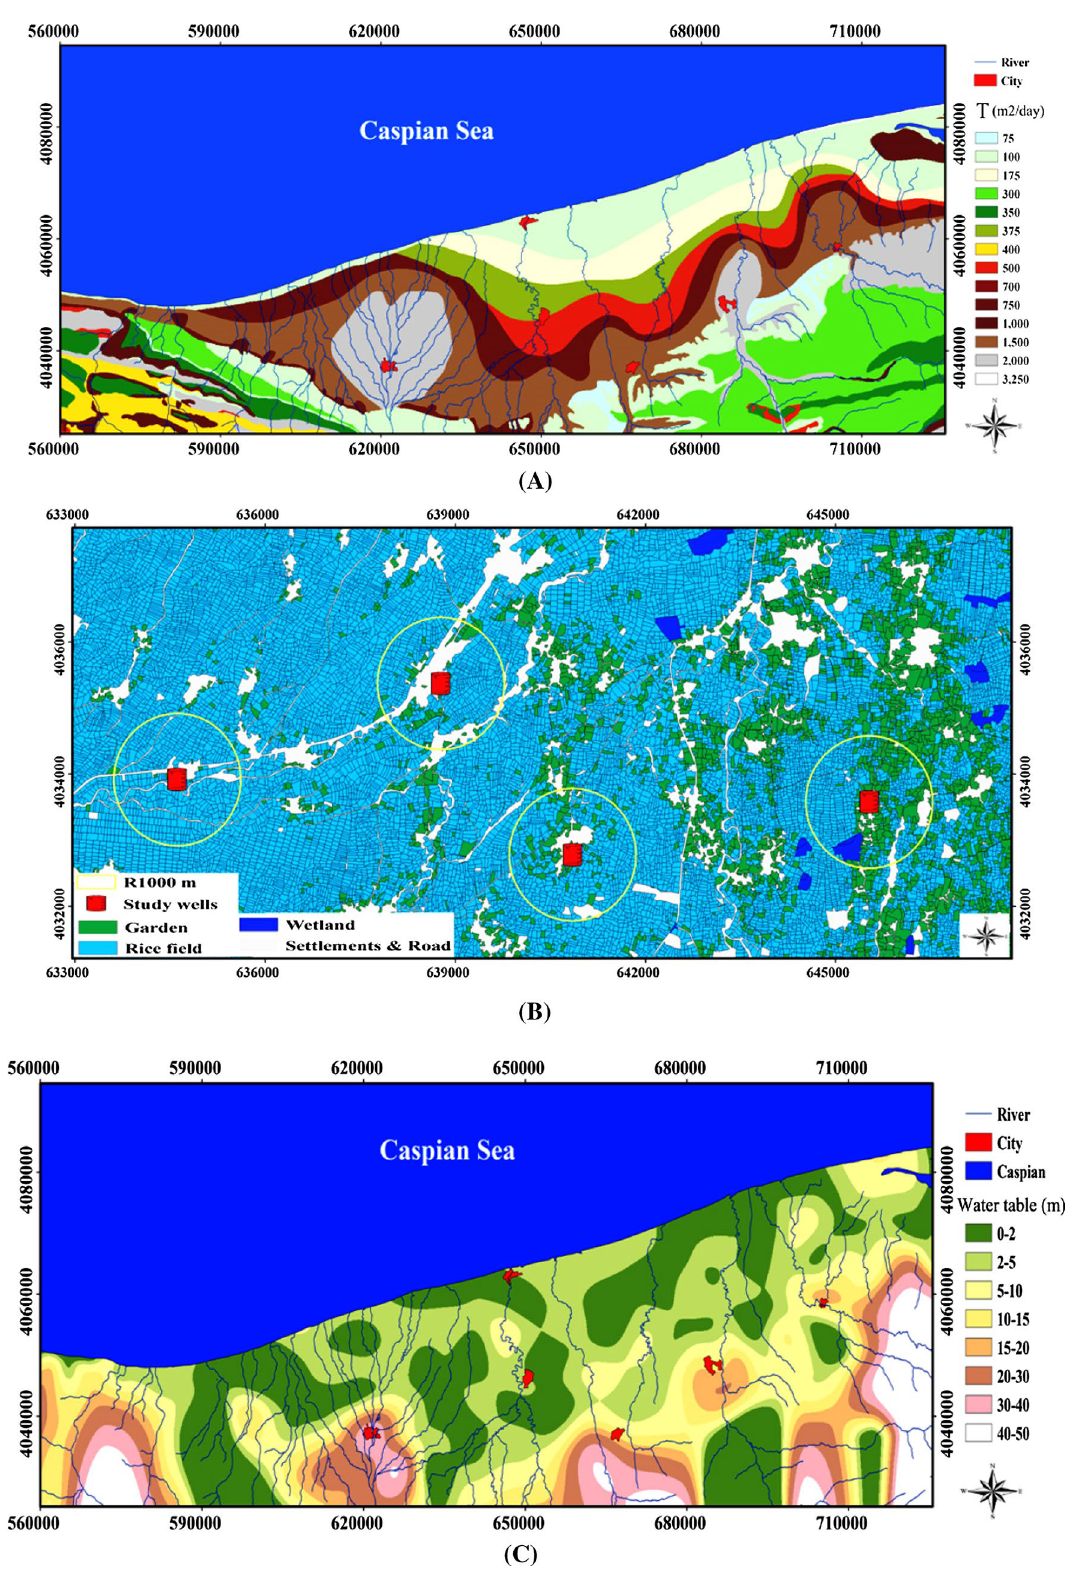
Fig. 4 Maps of effective factors in the annual groundwater drawdown. ( a ) The mean transmissivity of aquifer formations (m 2 /day), ( b ) the used land uses and the wells in the calculation of groundwater withdrawal values, and ( c ) the mean groundwater depth